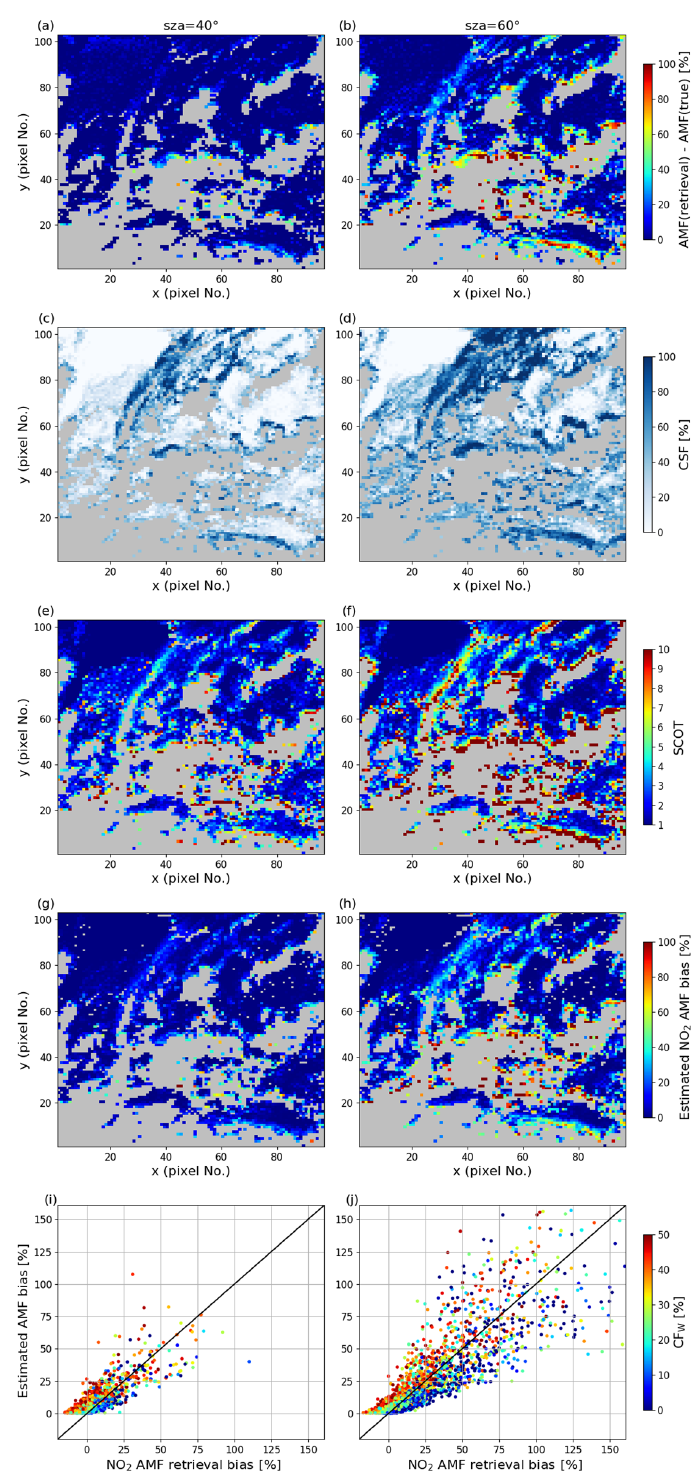
Figure 17. Example of our parameterization approach for the NO 2 retrieval bias in the cloud shadow for the LEO cases with surface albedo = 0 . 05, VZA = 0 ◦ , and SZA = 40 ◦ (a, c, e, g, i) and 60 ◦ (b, d, f, h, j) . Panels (a) and (b) show the bias of NO 2 retrieval based on the standard retrieval algorithm using O 2 –O 2 cloud correction. Grey shaded pixels indicate cloudy pixels. Panels (c) and (d) are the cloud shadow fraction. Panels (e) and (f) are the averaged slant cloud optical thickness. Panels (g) and (h) are the estimated NO 2 bias using the Eq. (9). Panels (i) and (j) compare the true retrieval bias with the estimation; only the pixels with the cloud shadow fraction > 10% and slant cloud optical thickness > 1 are used in the analysis. The colours represent the cloud radiance fraction from the retrieval.